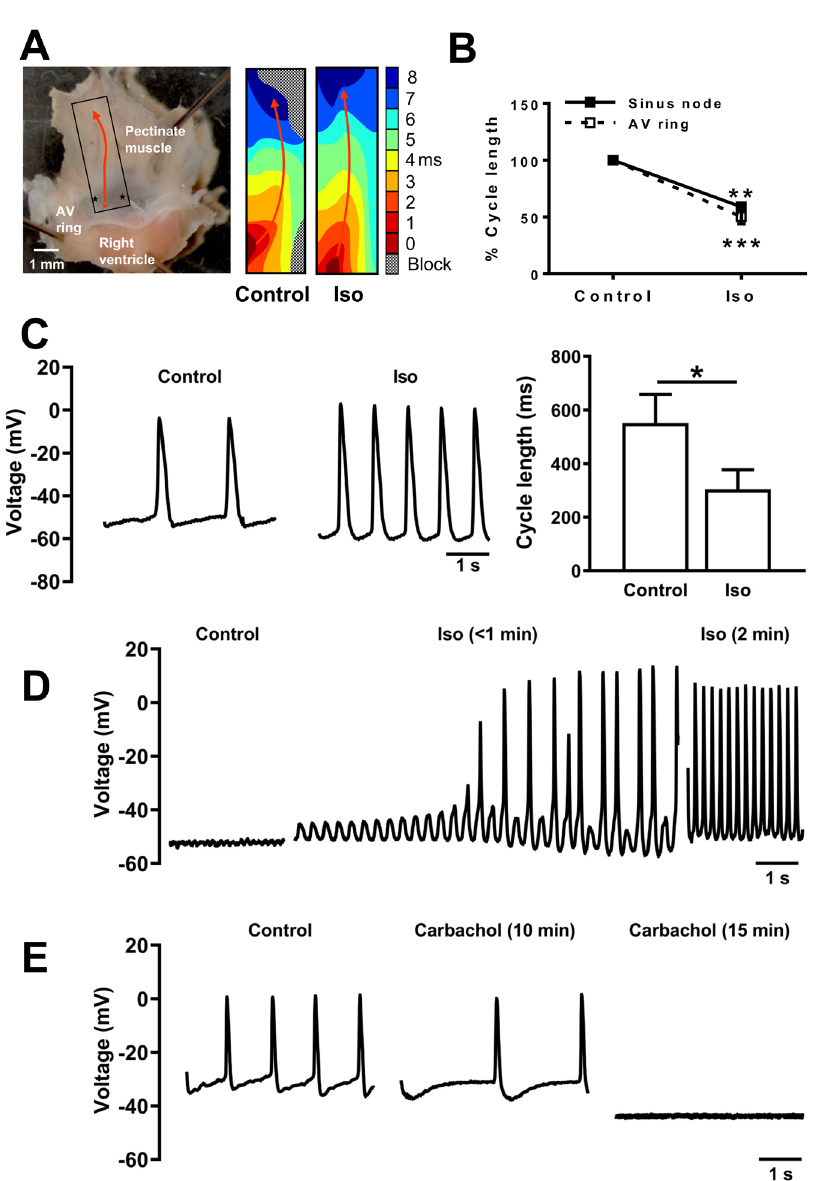
Figure 5. Autonomic modulation of pacemaker activity. ( A ) Typical isolated atrioventricular ring (AV ring) preparation. Box denotes mapping array (6 × 10 electrodes) position, red star and arrow, initiation site and direction of action potential propagation. Scale bar denotes 1 mm. Isoproterenol (Iso) unmasked additional ectopic pacemakers (black stars) and overcame conduction blocks. Electrical activation maps for control and Iso shown. ( B ) Cycle length data from mapping array recordings under control and in iso for sinus node (black squares and continuous line; n = 3) and isolated AV ring (white squares and dashed line; n = 5). Two-way ANOVA with Sidak multiple comparisons post-test was used for statistical comparison. Black asterisks denote significant difference vs . respective control. ( C ) Representative records of AV ring pacemaker action potentials under control and in iso. Action potential cycle length is shown in bar chart (n = 4 cells in 4 AV rings). ( D ) Iso induced pacemaker action potentials in a quiescent AV ring. ( E ) Carbachol (0.05 µ M) abolished pacemaking in AV ring. * P ≤ 0.05, ** P ≤ 0.01, *** P ≤ 0.001. For action potential records in ( C – E ) scale bars represent 1